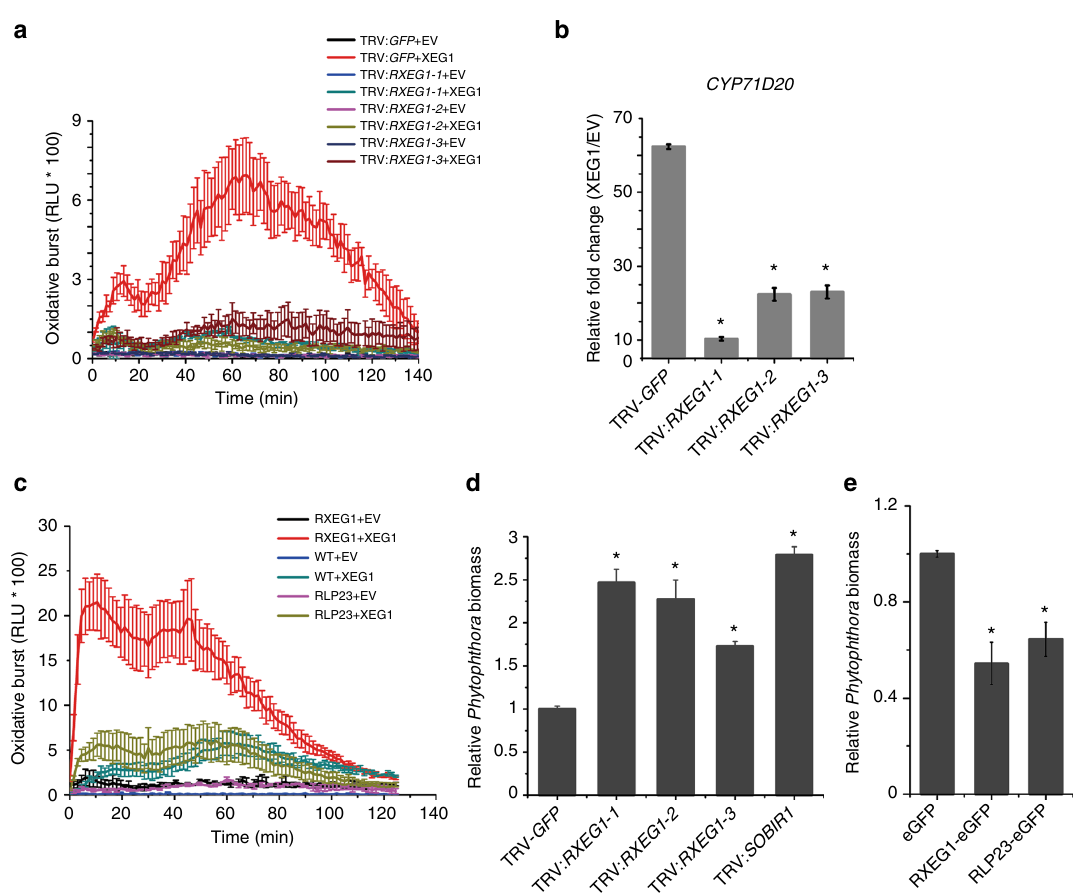
Fig. 3 RXEG1 participates in XEG1-induced plant immunity. a, c Production of reactive oxygen species (ROS) in RXEG1 -silencing ( a ) or overexpressing ( c ) N . benthamiana treated with 1 μ M XEG1 or control (EV). Mean values ( ± s.e.m.) of four replicates are shown. Experiments were repeated twice with similar results. b Relative expression of defense-related marker gene CYP71D20 in RXEG1 -silencing N . benthamiana leaves 3 h after treatment with 200 n M XEG1 or EV. Transcript levels were quanti fi ed by qRT-PCR and normalized to EF-1 α . Bars represent the mean fold changes ( ± s.e.m.) of the XEG1-treated leaves relative to the value in EV-treated leaves, which was set as 1. *, signi fi cant differences ( P < 0.05, Student ’ s t -test). Experiments were repeated three times with similar results. d, e Relative quanti fi cation of P . parasitica biomass using qPCR. Infected leaves ( n = 12) were collected at 3 days post inoculation (dpi) and used for DNA isolation and qPCR analysis. *, signi fi cant differences ( P < 0.05, Student ’ s t -test). Experiments were repeated twice